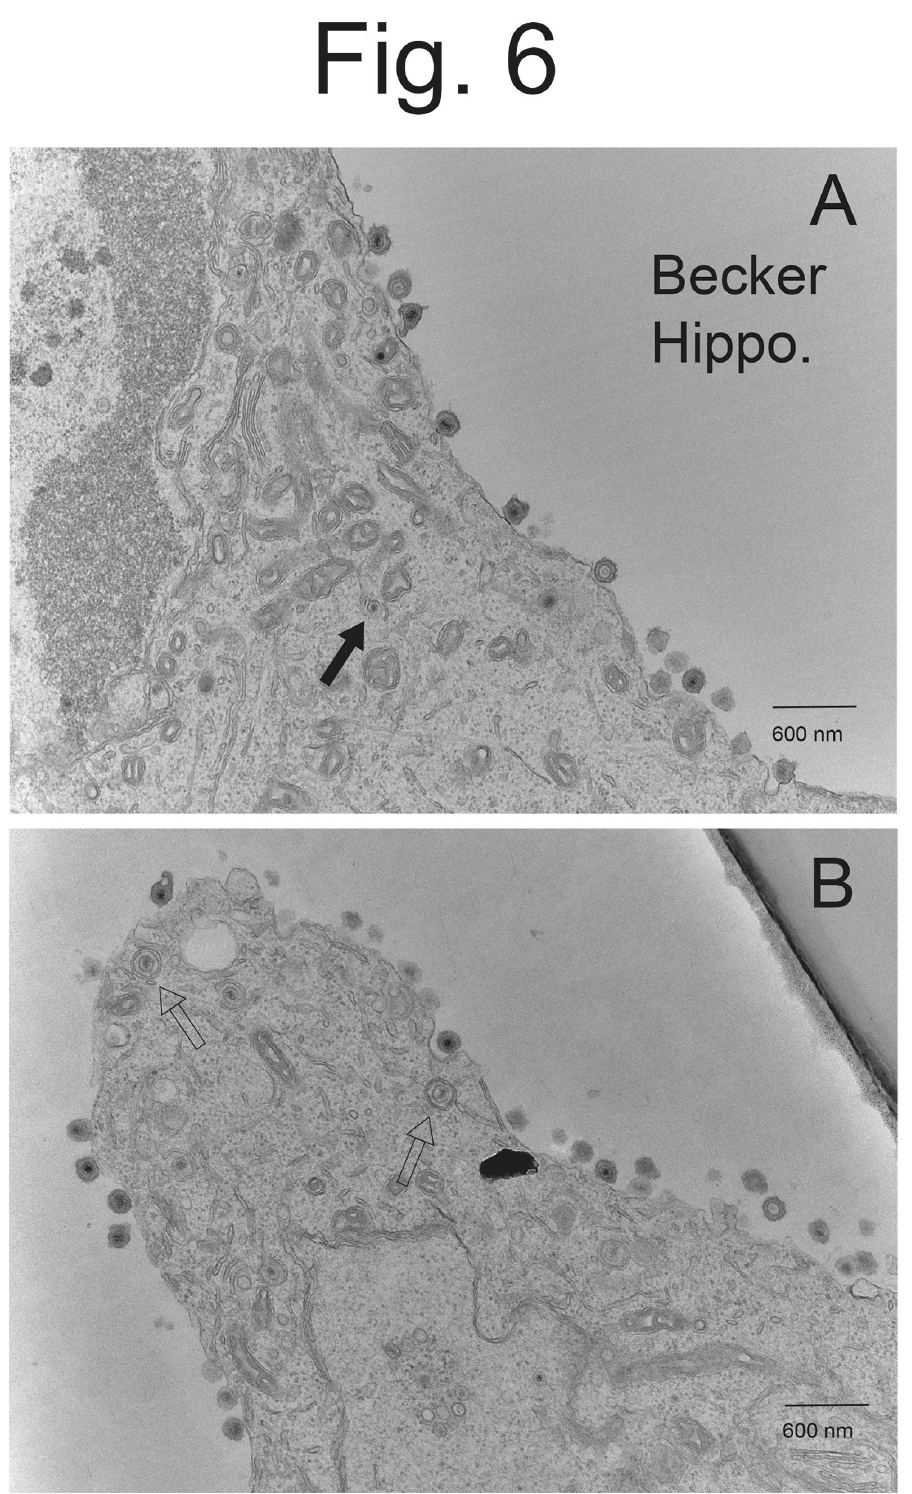
Figure 6. Higher magnification EM of hippocampal neurons infected with PRV Becker. Hip- pocampal neurons on Thermanox slides were infected with PRV Becker for 10–12 h then processed for EM. Panel ( A ) shows largely enveloped cell surface virions. There was one capsid in the cytoplasm associated with a membrane (solid arrow). Panel ( B ) shows cell surface virions and fewer cytoplasmic enveloped and partially enveloped virions (empty